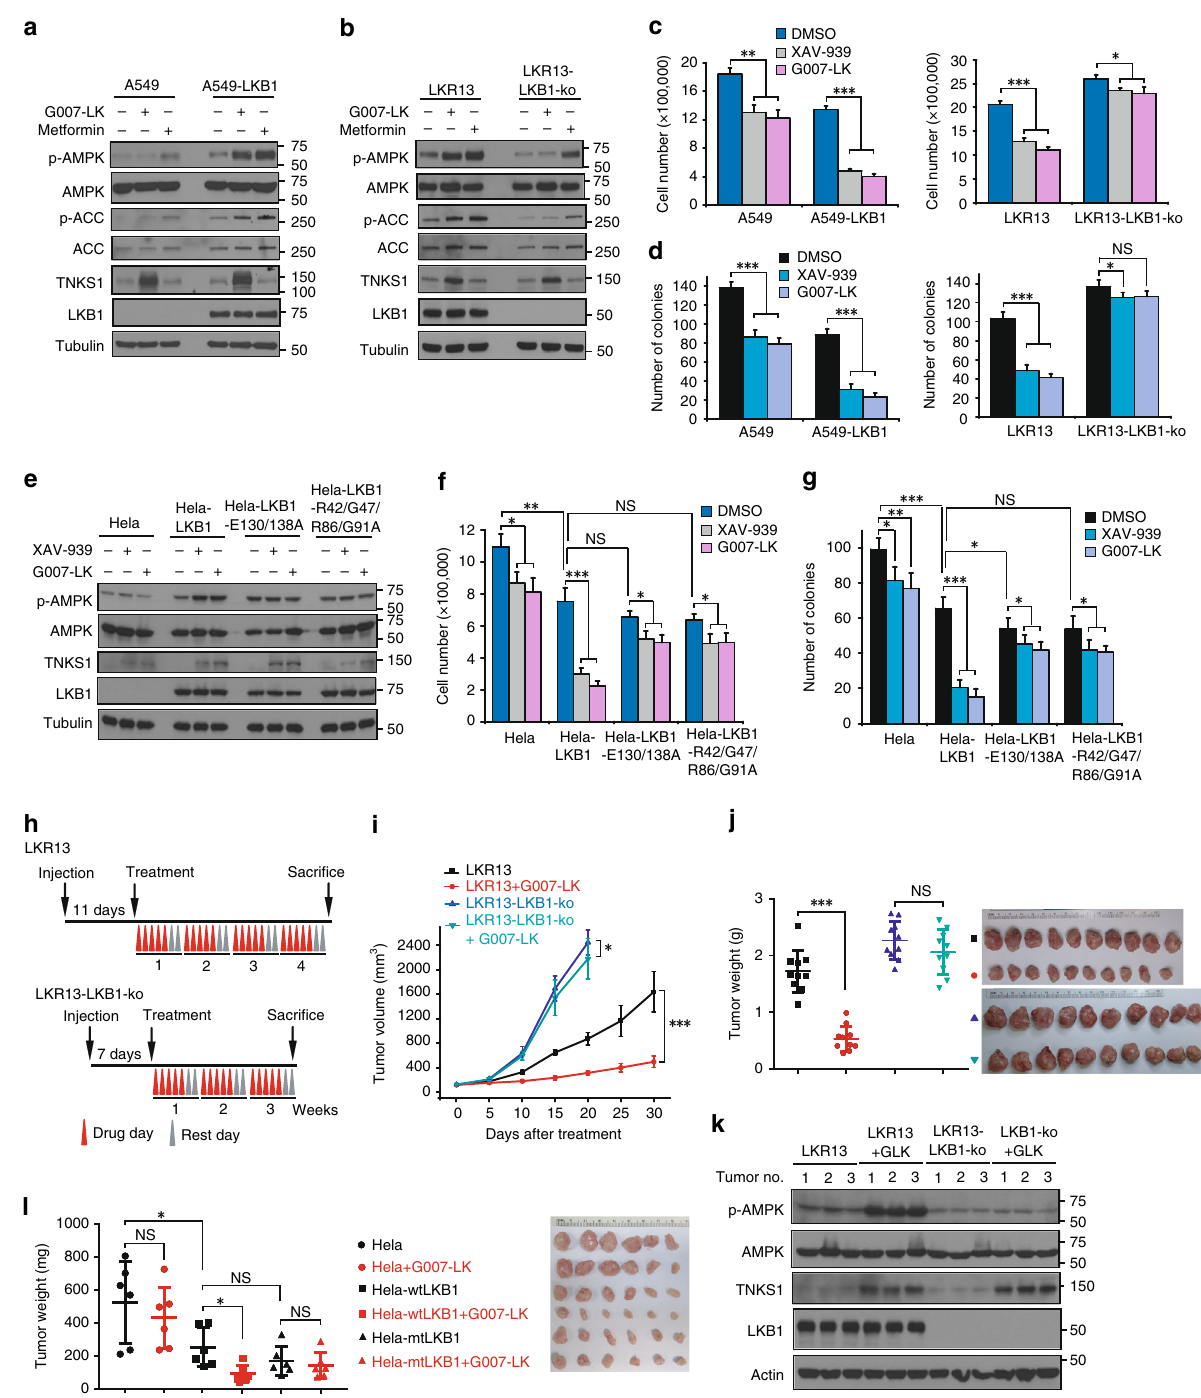
affect LKB1 protein levels (Fig. 3a), we reasoned that RNF146 could regulate the LKB1-AMPK pathway through a nondegra- dative mechanism. As K48-linked ubiquitination normally triggers proteasome degradation but K63-linked ubiquitination is the signal for nondegradative functions 36 , we considered the possibility that RNF146 may regulate AMPK activation by K63- linked ubiquitination. We used K48R and K63R-ubiquitin for an in vivo ubiquitination assay and found that K63R, but not K48R- ubiquitin, blocked RNF146-mediated LKB1 ubiquitination (Fig. 3g). We also found that RNF146 only induced incorporation of K63-ubiquitin into LKB1 (Supplementary Fig. 4e) and that NATURE COMMUNICATIONS| (2019) 10:4363